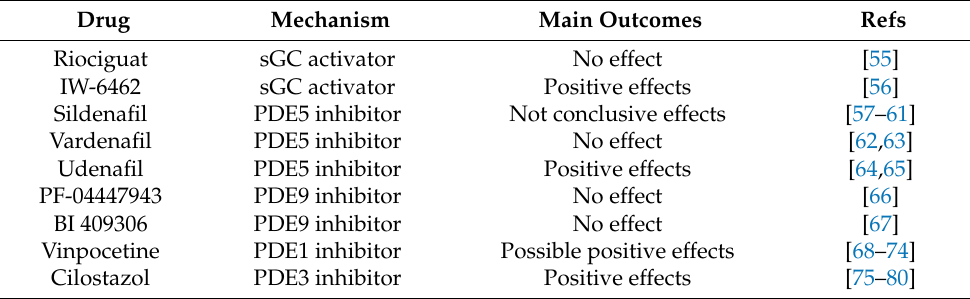
Table 1. cGMP enhancers in clinical studies on cognitive